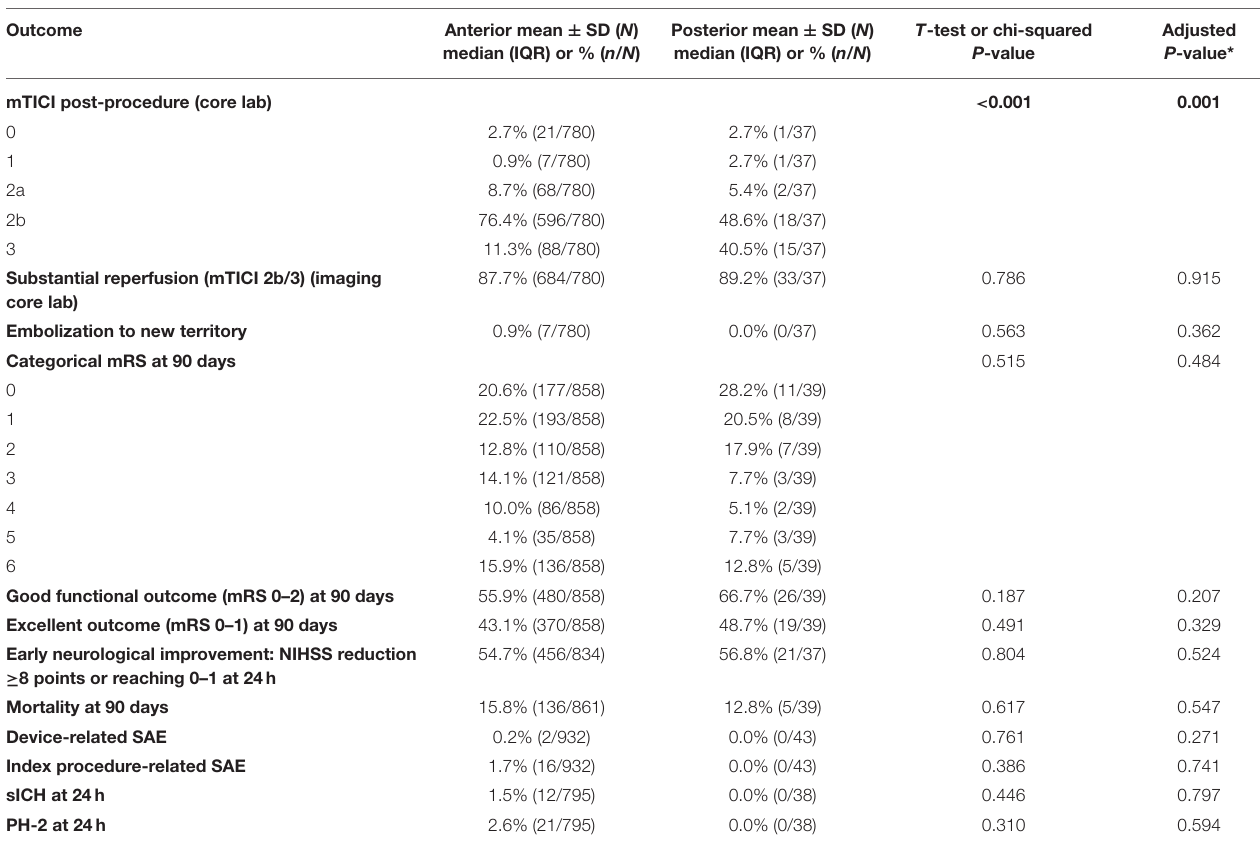
TABLE 3 | Technical, clinical, and safety outcomes. Outcome Anterior mean ± SD ( N )